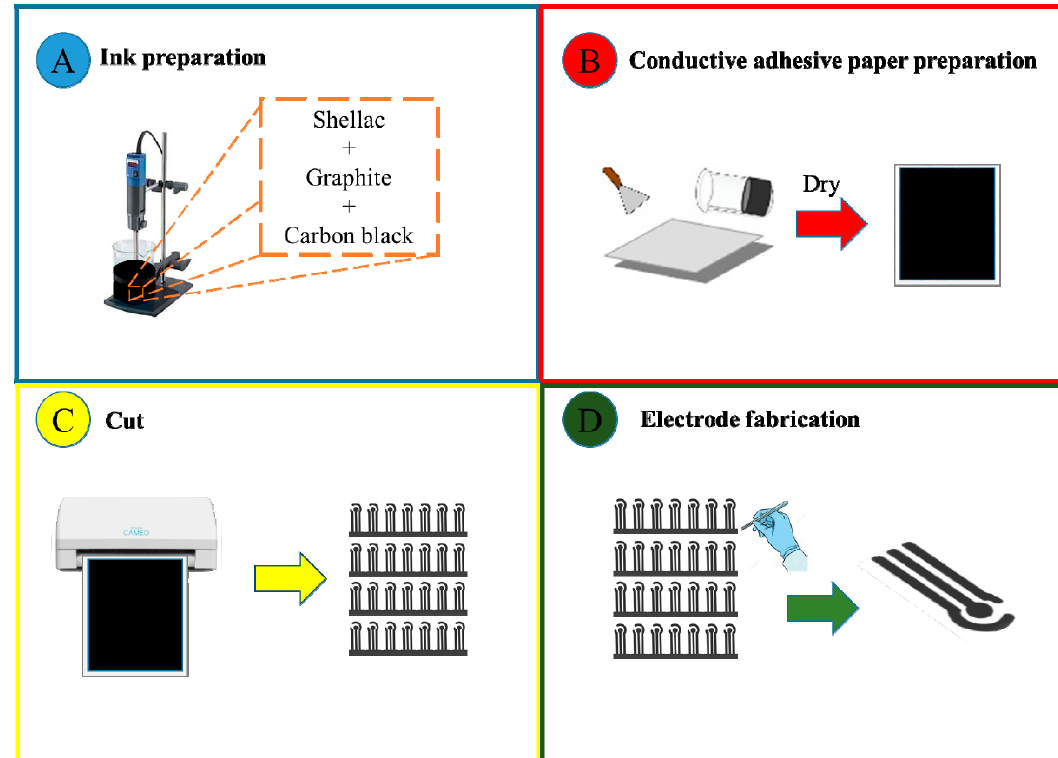
Figure 1. Preparation of disposable electrodes using a simple approach: ( A ) conductive ink preparation; ( B ) application of the conductive ink on a sheet of self-adhesive paper; ( C ) the devices were cut using